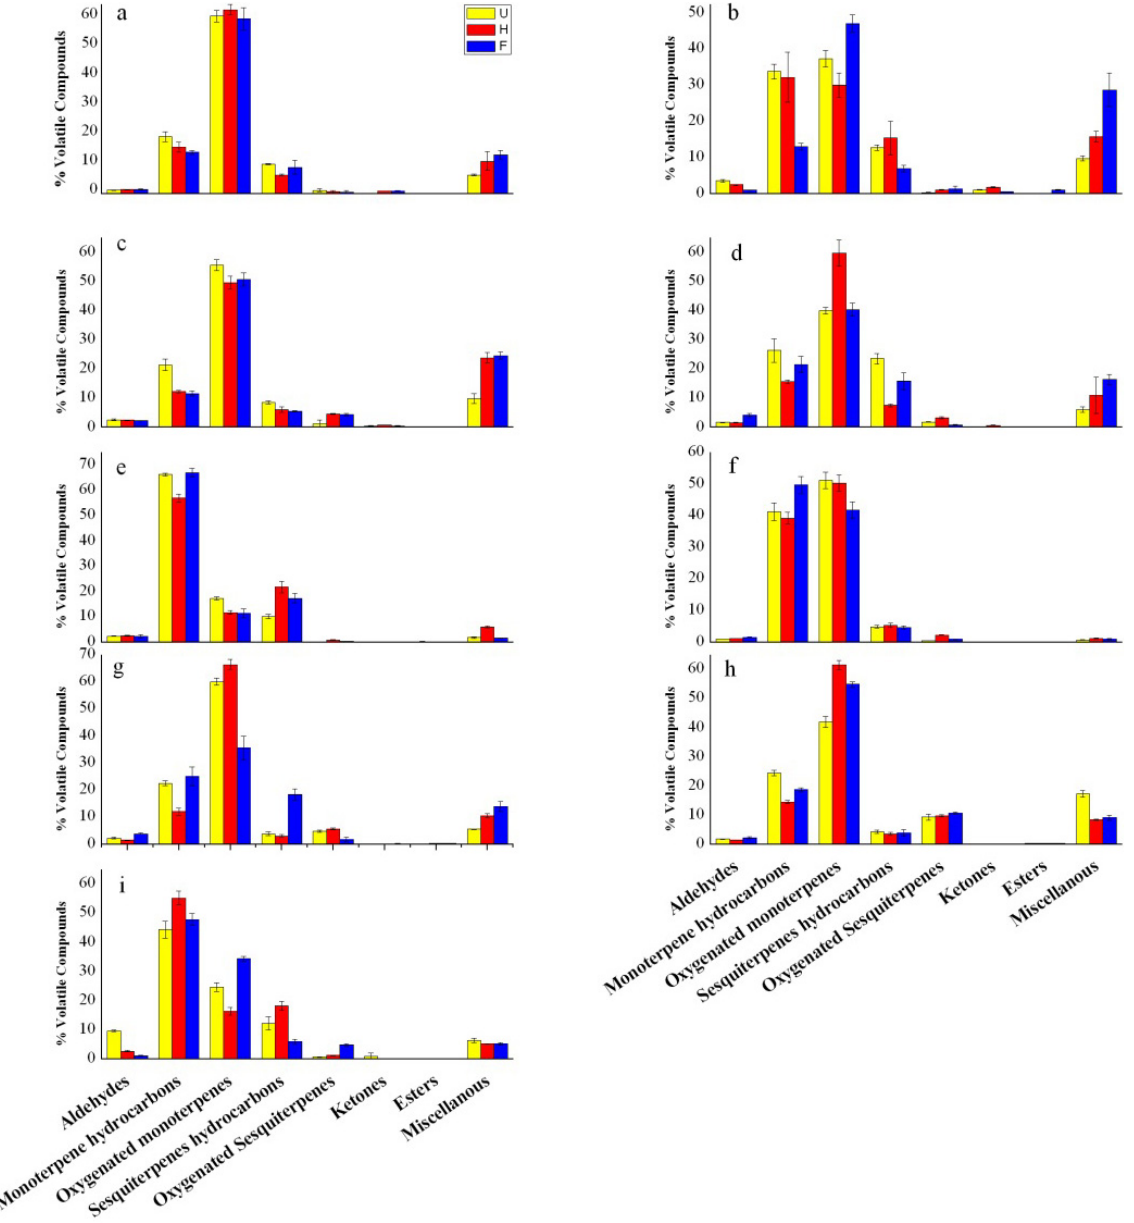
Figure 2. Evolution of each group of flower volatile compounds during blooming in the Ponkan ( a ); Satsuma ( b ); Qingjia ( c ); Liubencheng ( d ); Eureka ( e ); Bergamot ( f ); Yuhuanyou ( g ); Zaoxiangyou ( h ); and Huyou ( i ); Citrus flowers were sampled at unopened flower “U”, half opened “H”, and fully opened flower “F” blooming